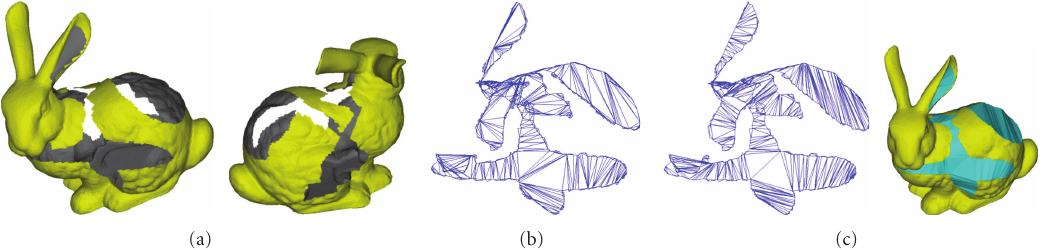
Figure 15: Triangulation results comparison. (a) Bunny model with complex hole. (b) Triangulation result by Barequet and Sharir [18]. (c) Triangulation result by the method in this